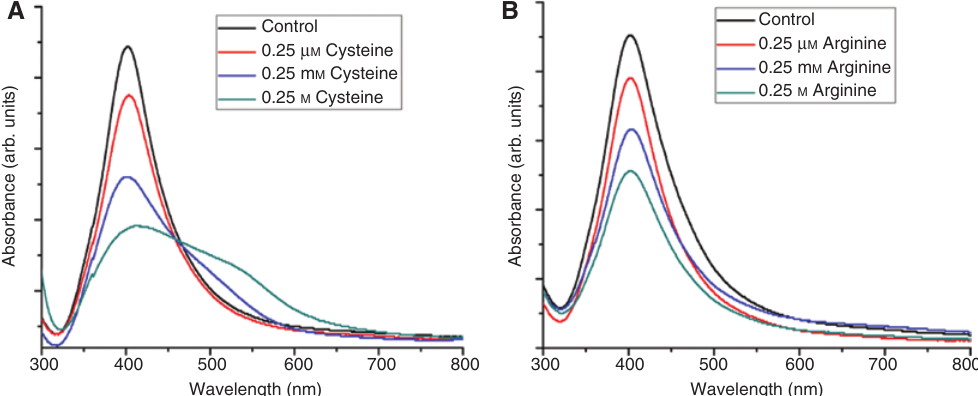
Figure 3: Variation of SPR peak profile of AgNPs on exposure to different concentrations of (A) Cys and (B) Arg.